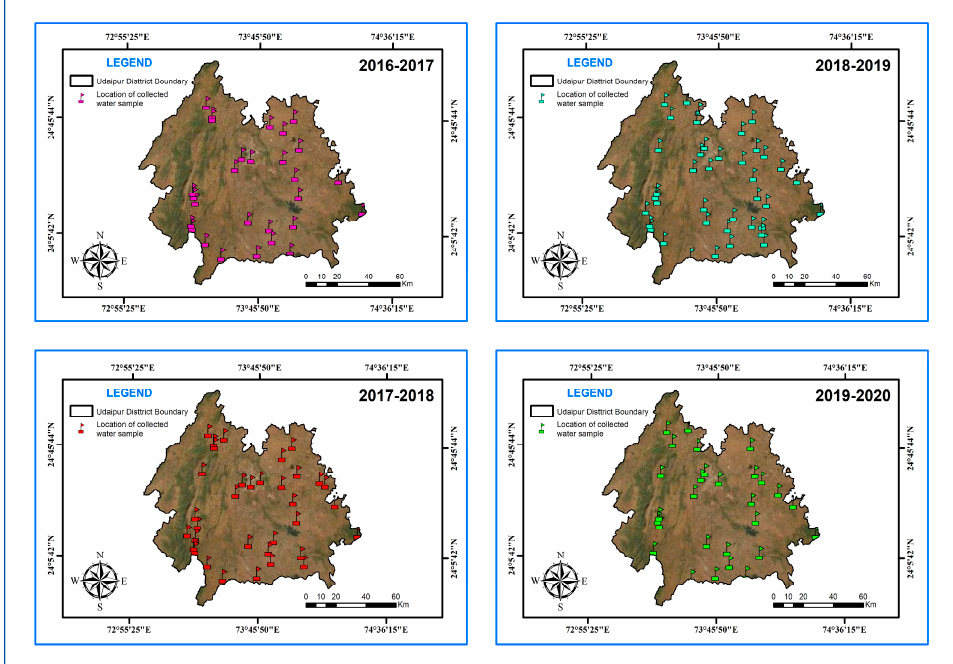
Figure 13. The location of collected samples for chemical analysis.